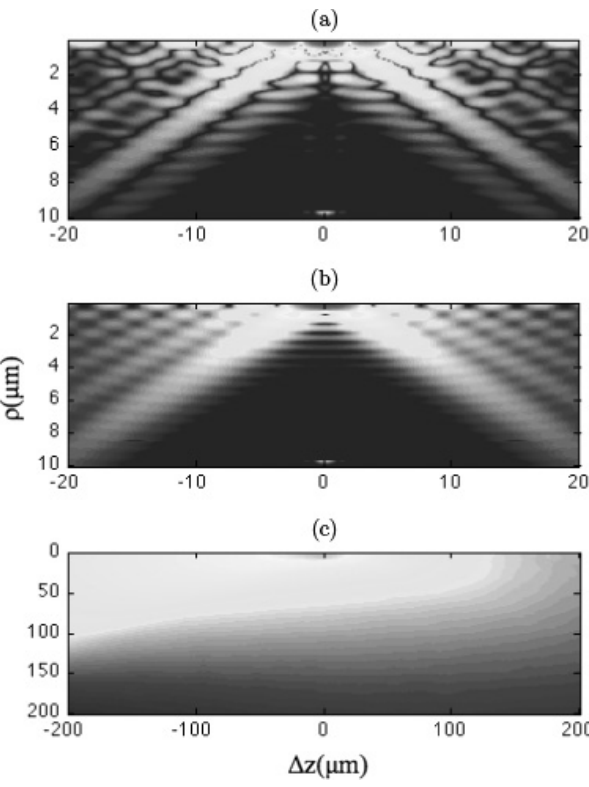
Fig. 5. (a) FMM equivalent PSF compared with (b) the bal- listic excitation rate and (c) scattered excitation rate of CM.